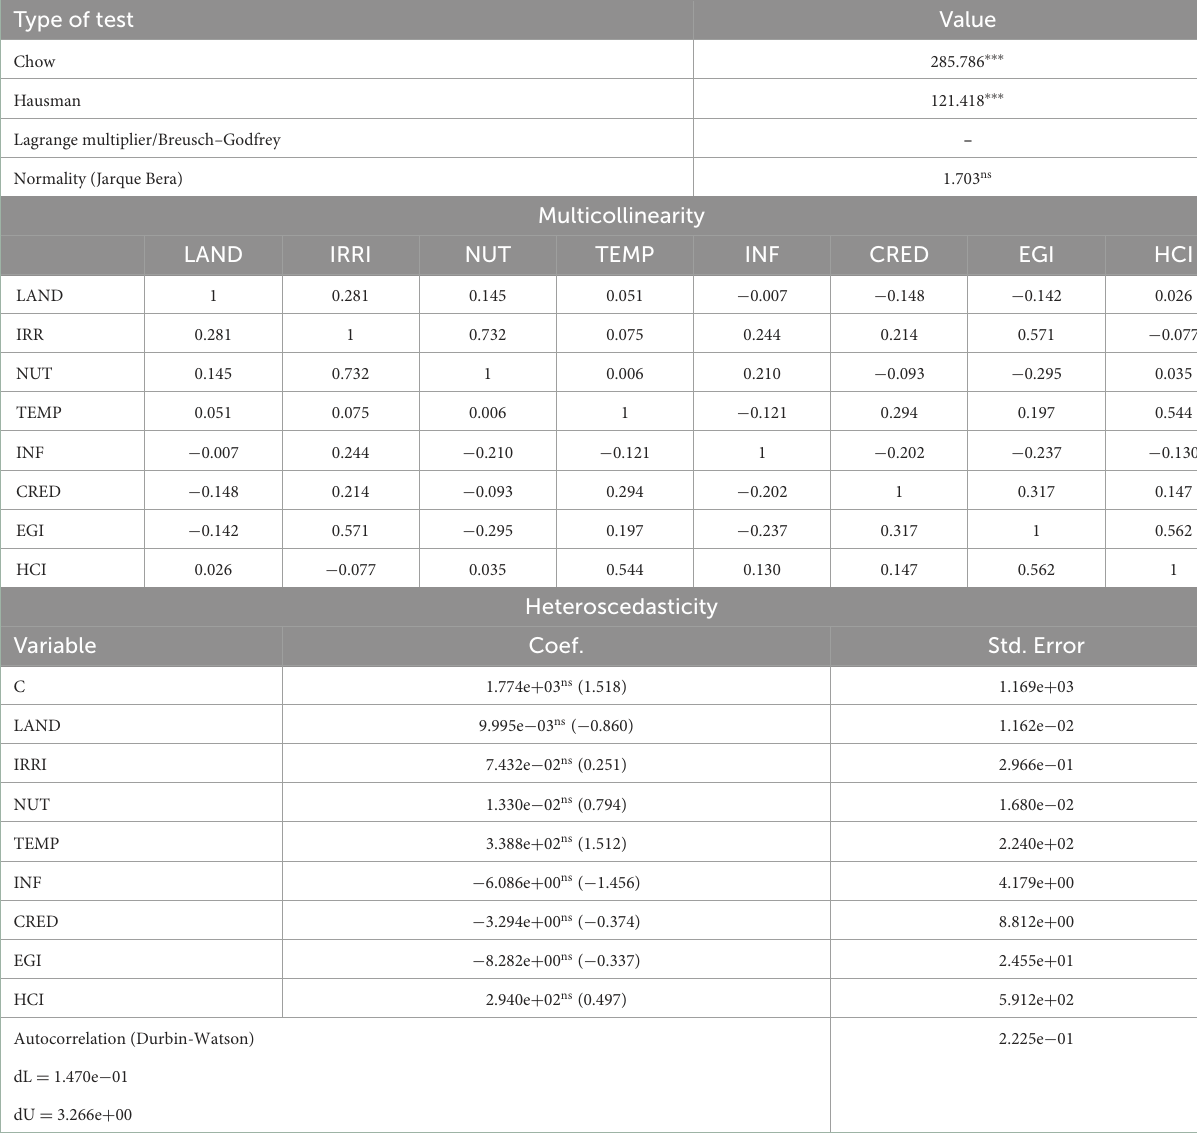
TABLE 3 The results of Chow, Hausman, normality, multicollinearity, heteroscedasticity, and autocorrelation tests. Type of